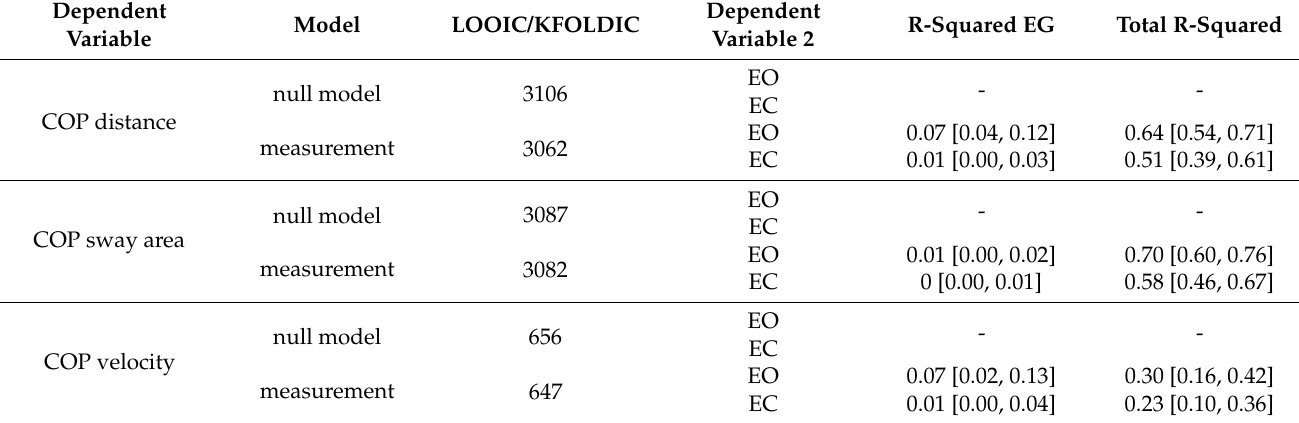
Table 1. Fitness of the regression models to the dataset used in this paper for testing changes in experimental group.